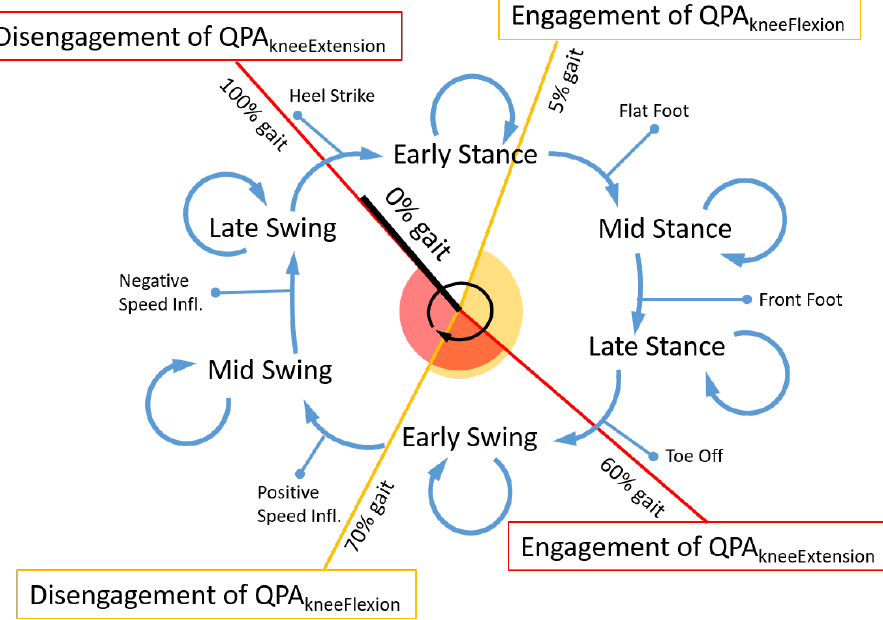
Figure 3. Control flow of the finite state machine (FSM), in which the events (heel strike, flat foot, front foot, toe off, positive speed inflection and negative speed inflection) determining the state changes are